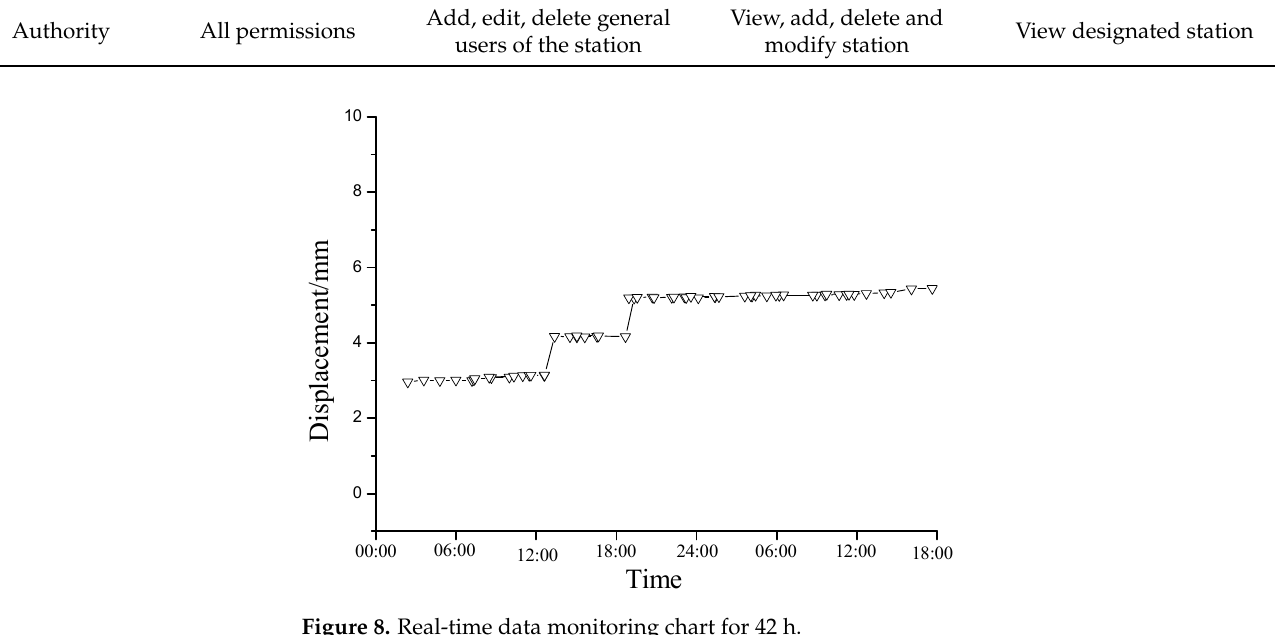
Figure 8. Real-time data monitoring chart for 42 h.